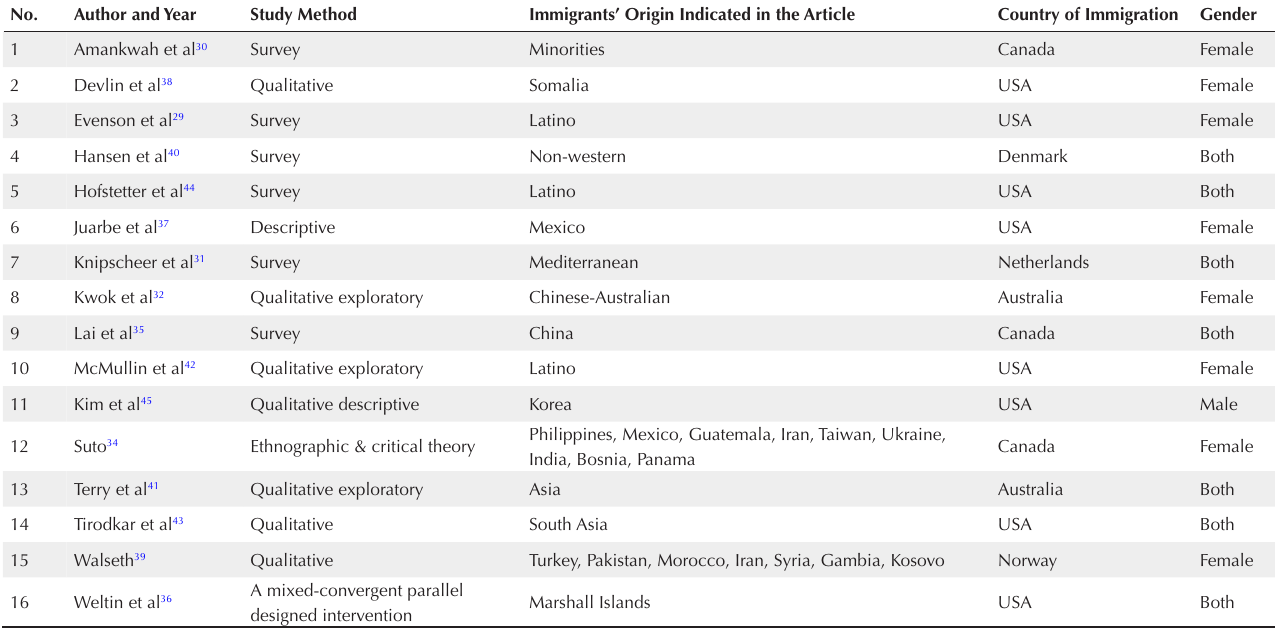
Table 2. Demographic Characteristics of Participants in Studies in This Review